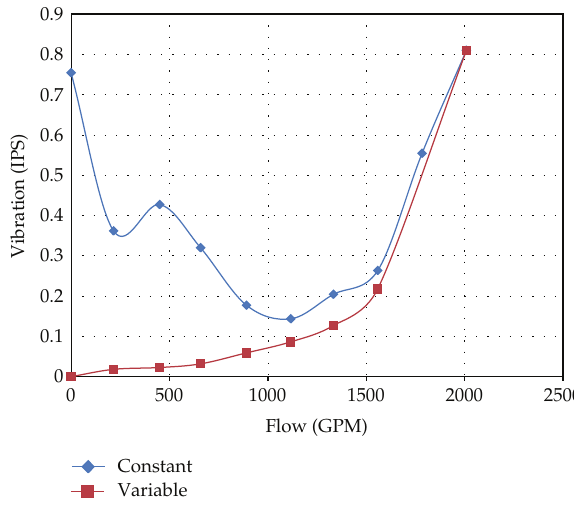
Figure 4: Vibration levels for di ff erent operating models of the same